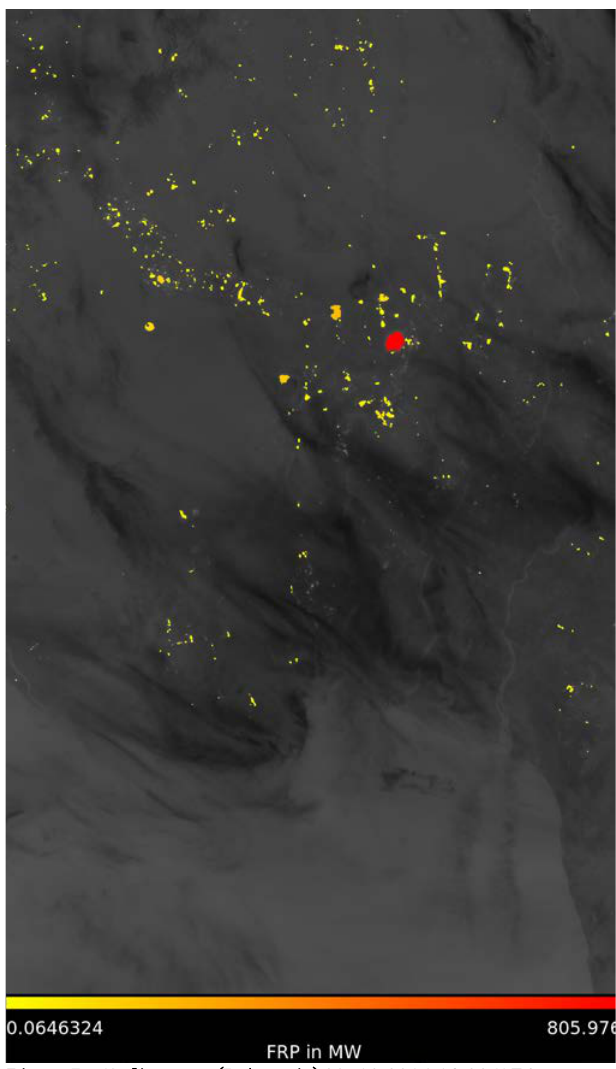
Figure 7. Kalimantan (Indonesia) 09. 10.2014 16:33